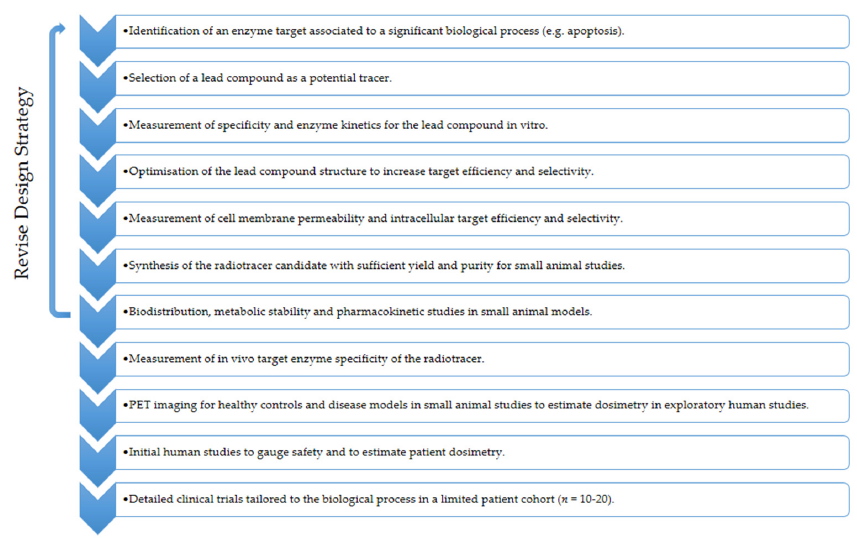
Figure 2. Development process for successful enzyme radiotracers.